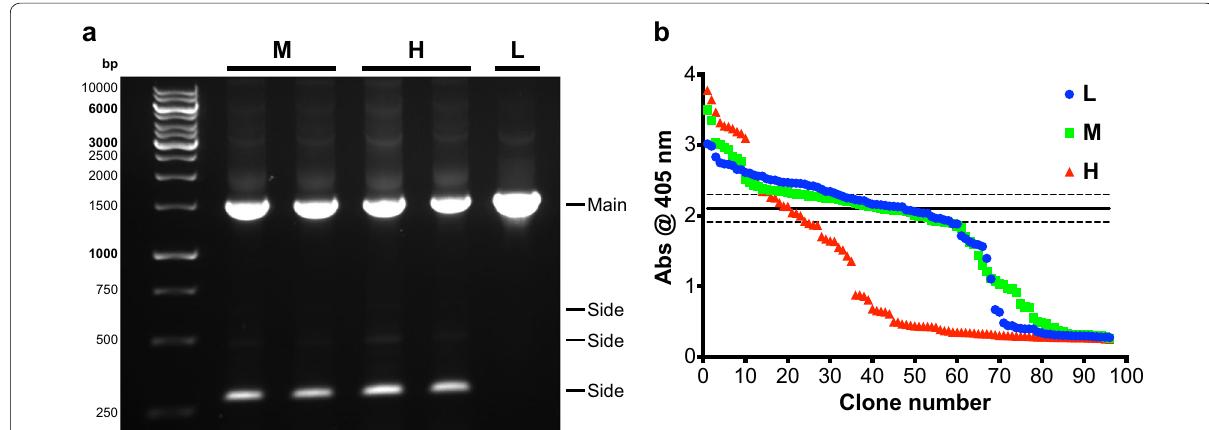
Fig. 2 a Products and side products of epPCRs with high (H), medium (M) and low (L) mutation rates. b ABTS oxidation activity values (Abs 405 ) of OsmY‑DyP4 mutant libraries from the 3rd round of epPCR [blue—epPCR library with low (L) mutation rate, green—epPCR library with medium (M) mutation rate, red—epPCR library with high (H) mutation rate]. Solid and dotted horizontal lines represent the average activity of parental strain (i.e. 2A5) and one standard deviation (SD) above/below the average value, respectively